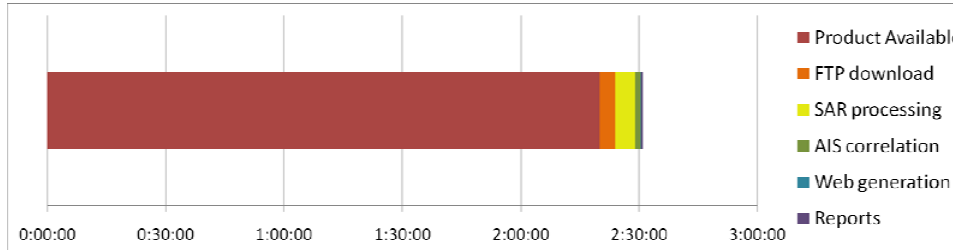
Figure 2. Timing in data processing for generating